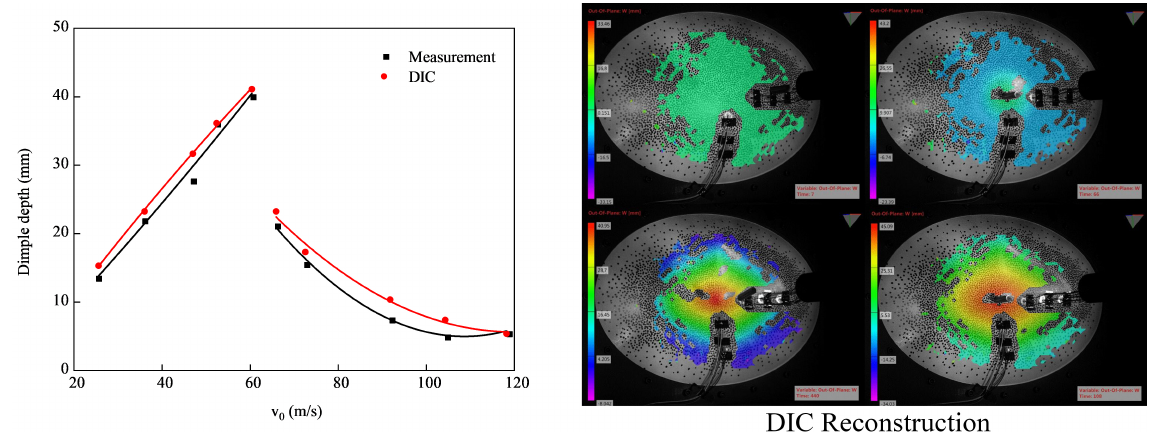
Figure 6. Comparison between dimple depth captured via DIC and via the static measurement of recovered specimens, which changed with impact